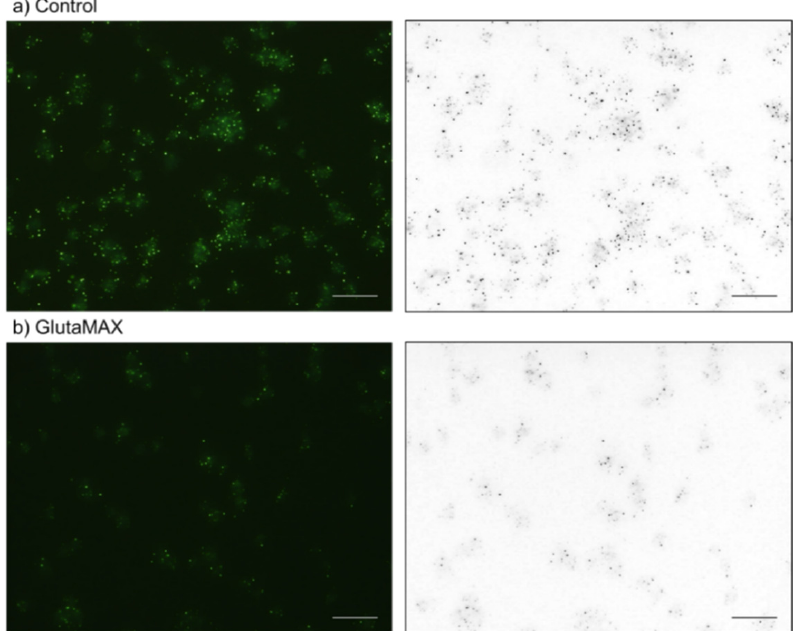
Figure 10. The effects of rotenone on platelet polyP (green and black microparticles in left and right columns, respectively). Platelets were treated with 20 μ M rotenone ( b ) for 20 h. The control contained only the solvent (DMSO) ( a ). Bar = 10 µ m. Similar results were observed in four other independent experiments.